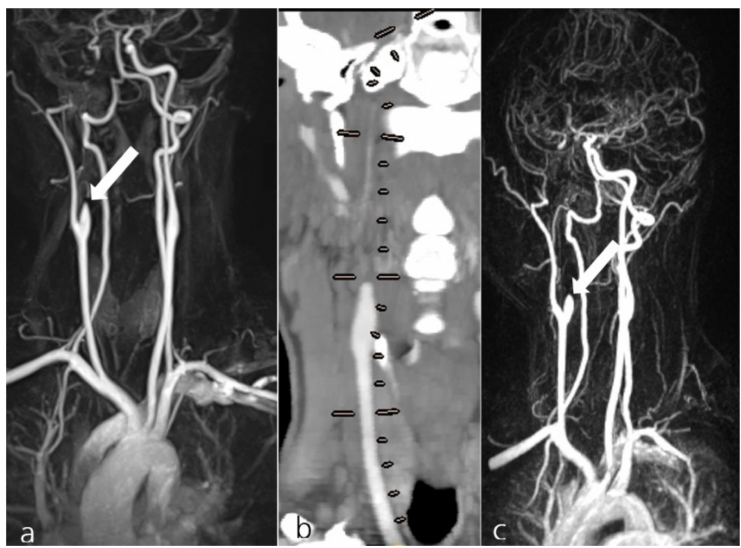
Figure 1. Exemplary display of patient #39 from group I, presenting with a spontaneous dissection of the right internal carotid artery ( a , arrow). The MRA shows the collateral supply for the occluded artery. The patient received 100 mg ASA and 90 mg Prasugrel PO daily. Follow-up examinations